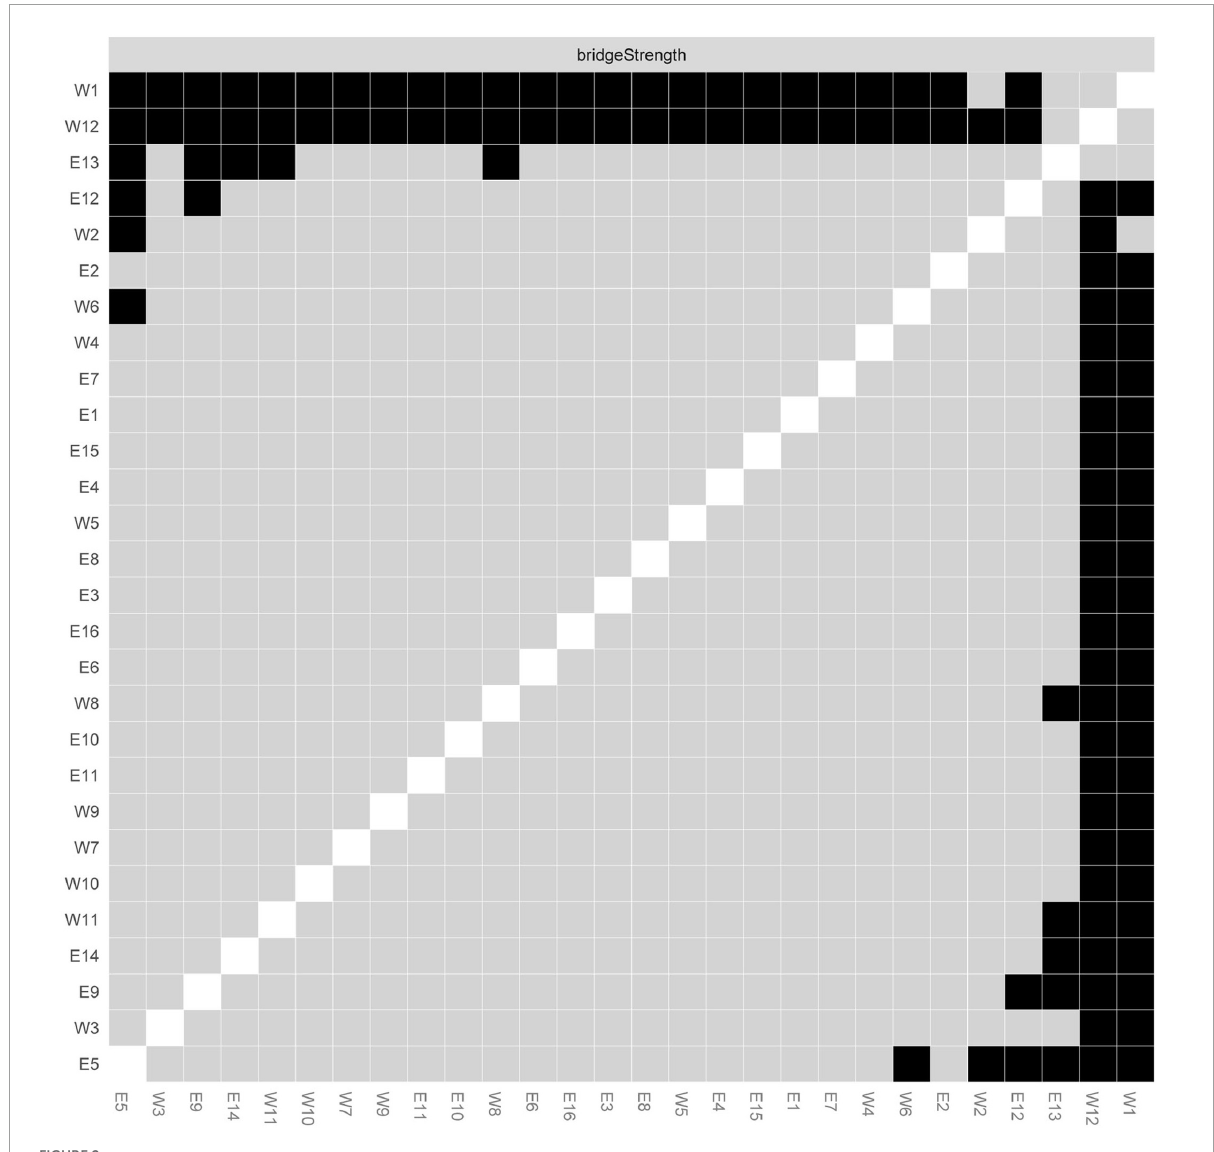
FIGURE2 Significance test of bridge strength centrality. The black box indicates that the bridge strength indices of the two corresponding nodes have a significant difference ( P < 0.05). The gray box indicates no significant difference ( P >